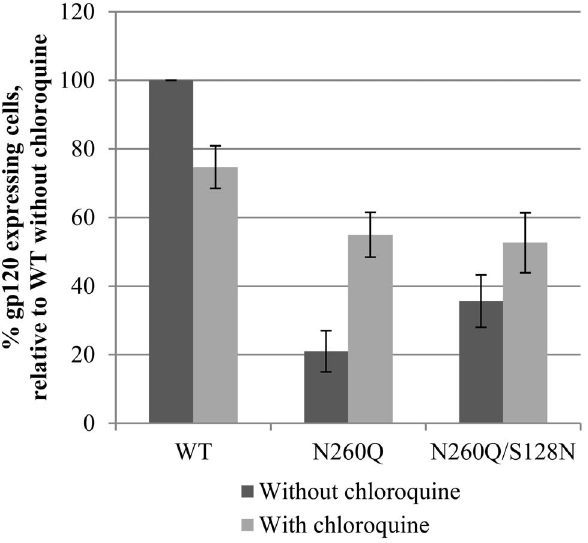
Figure 10. Capacity of WT and mutant virus strains, produced in the absence or presence of chloroquine, to bind to sCD4. 45 ng p24 of virus was lysed using Triton-X100 and was brought into contact with ELISA strips coated with sCD4. The binding efficiency was calculated as relative to the binding of WT virus produced in the absence of chloroquine. Data are the means ( 6 SEM) of 2–3 independent experiments.